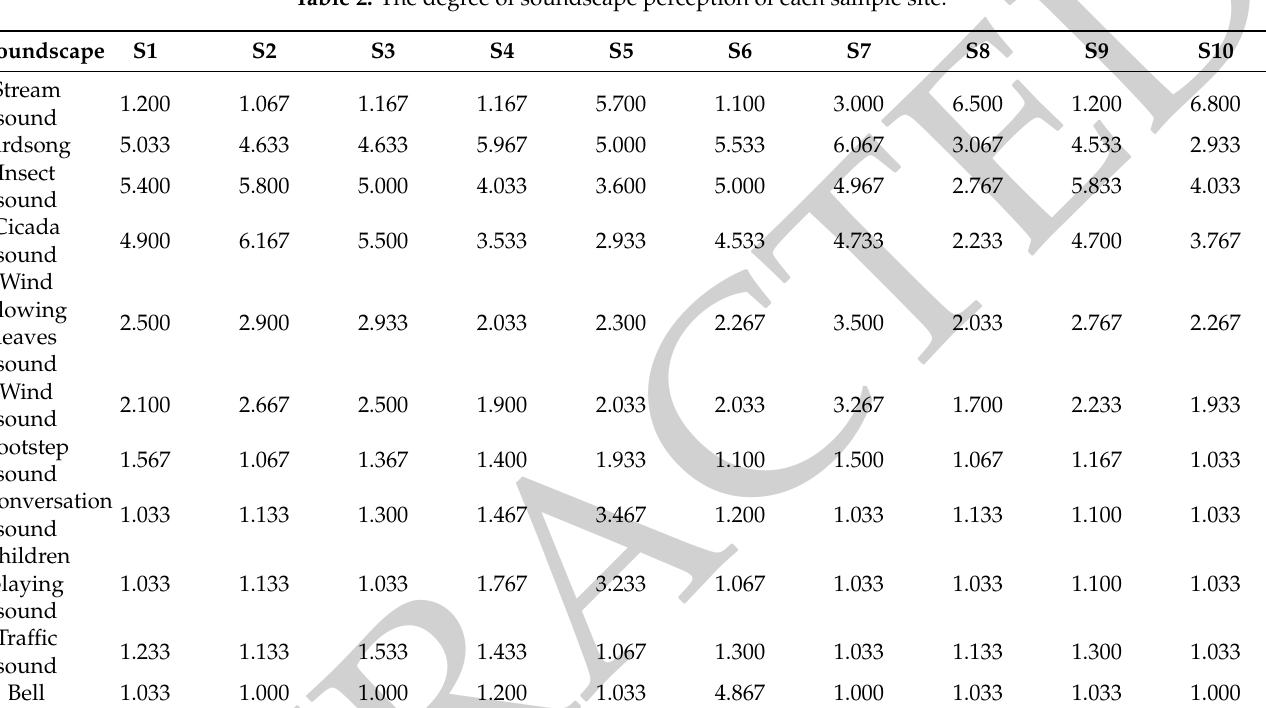
Table 2. The degree of soundscape perception of each sample